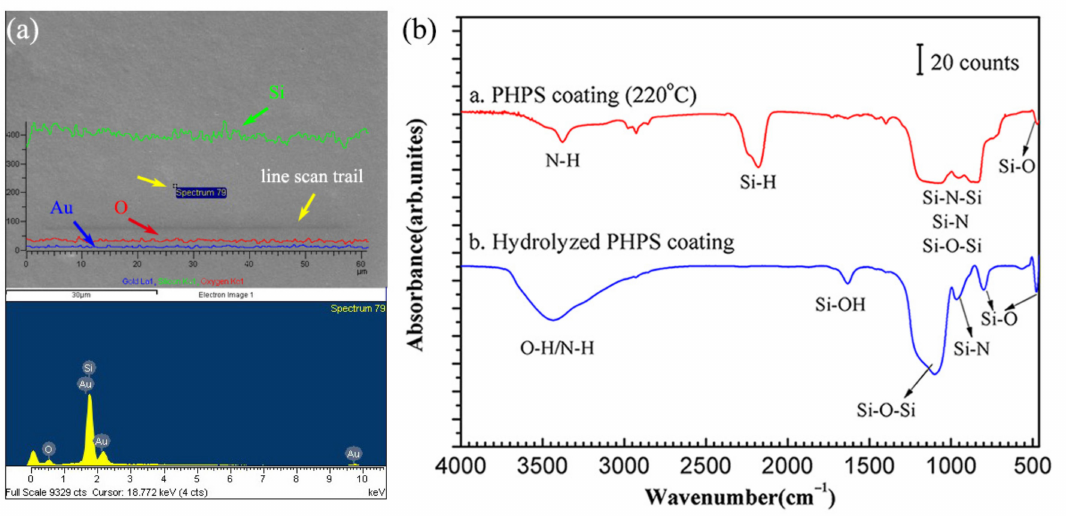
Figure 3. Chemical composition of the PHPS coating tested by ( a ) EDS line scan and point scan and ( b ) FTIR.